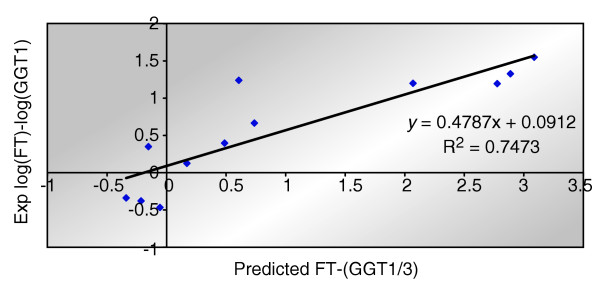
Correlation between predicted and experimental FT/GGT1 substrate selectivity. The correlation of the difference between predicted FT and GGT1 scores with the difference of the experimentally measured logarithmic affinities for FT and GGT1 of the same substrates is plotted.